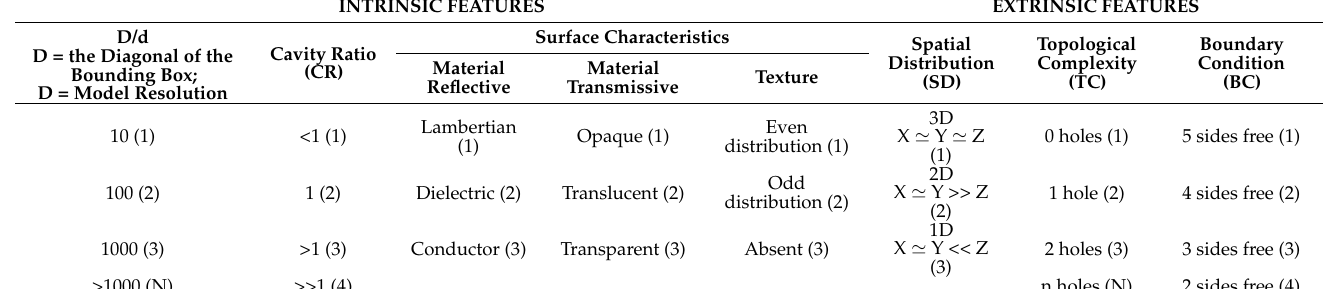
Table 1. Categories of acquisition complexity. Higher scores correspond to a higher complexity level.